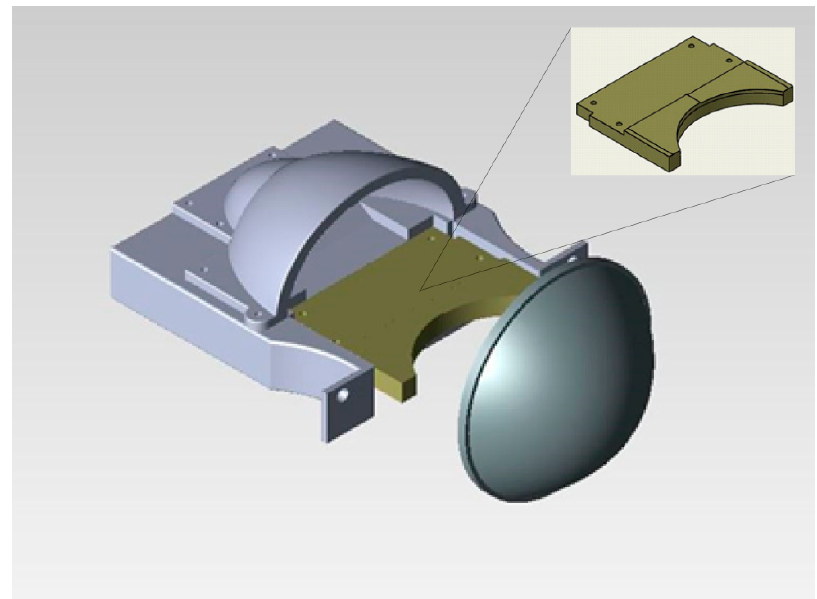
Figure 4. The structure of the projector-type LED headlamp in this study.